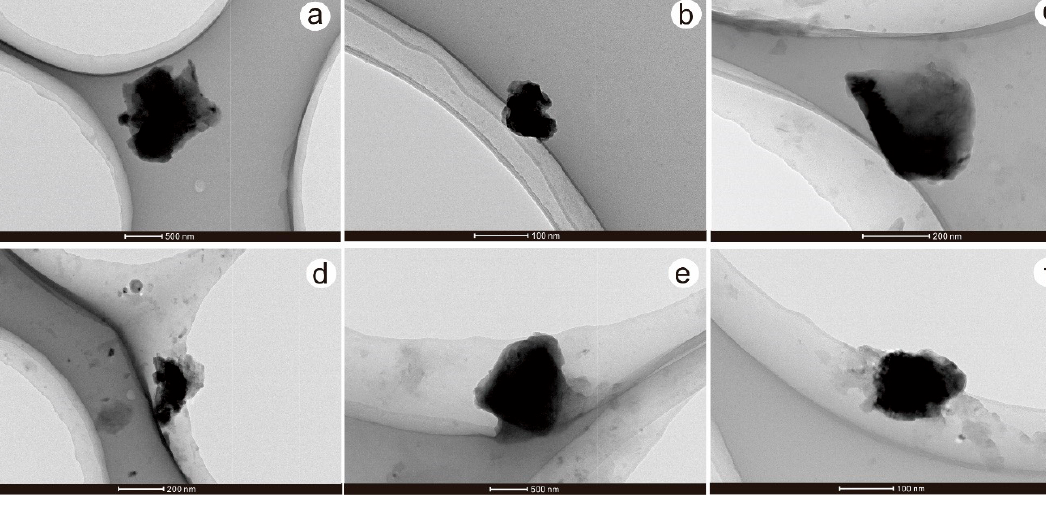
Figure 11. TEM images of Fe-bearing nanoparticles in the studied fault gouge samples. ( a ) Fe-bearing nanoparticles adsorbed to clay minerals; ( b ) Fe-bearing nanoparticles adsorbed to clay minerals; ( c ) a Fe-bearing nanoparticle. 4.2. Nanoparticles in the Geochemical Background Area More than 50 nanoparticles were investigated in the background soil samples. Most of them are Fe-, Al-, Si-, Ca-, Ti-, and Ba-bearing nanoparticles. Although a few particles contain Cu, Pb, and Zn, the content of these ore-forming elements are usually lower than 1%. Hematite, clay minerals, quartz, and amorphous carbon particles are the most common nanoparticles observed in background soil samples. 4.3. The Concentration of Ore-Forming Elements in Soil Samples, Fault Gouge Samples, and Ore Samples The ore-forming chemical element concentrations in various media are displayed in Table 4. The mean value of Au reaches up to 3520 ng/g in the ore samples. By contrast, the mean value of Au in fault gouge samples is 429 ng/g, in soil samples over the concealed ore bodies is 14.1 ng/g, and in soil samples from background area is 2.28 ng/g. The results show that Au concentrations are the highest